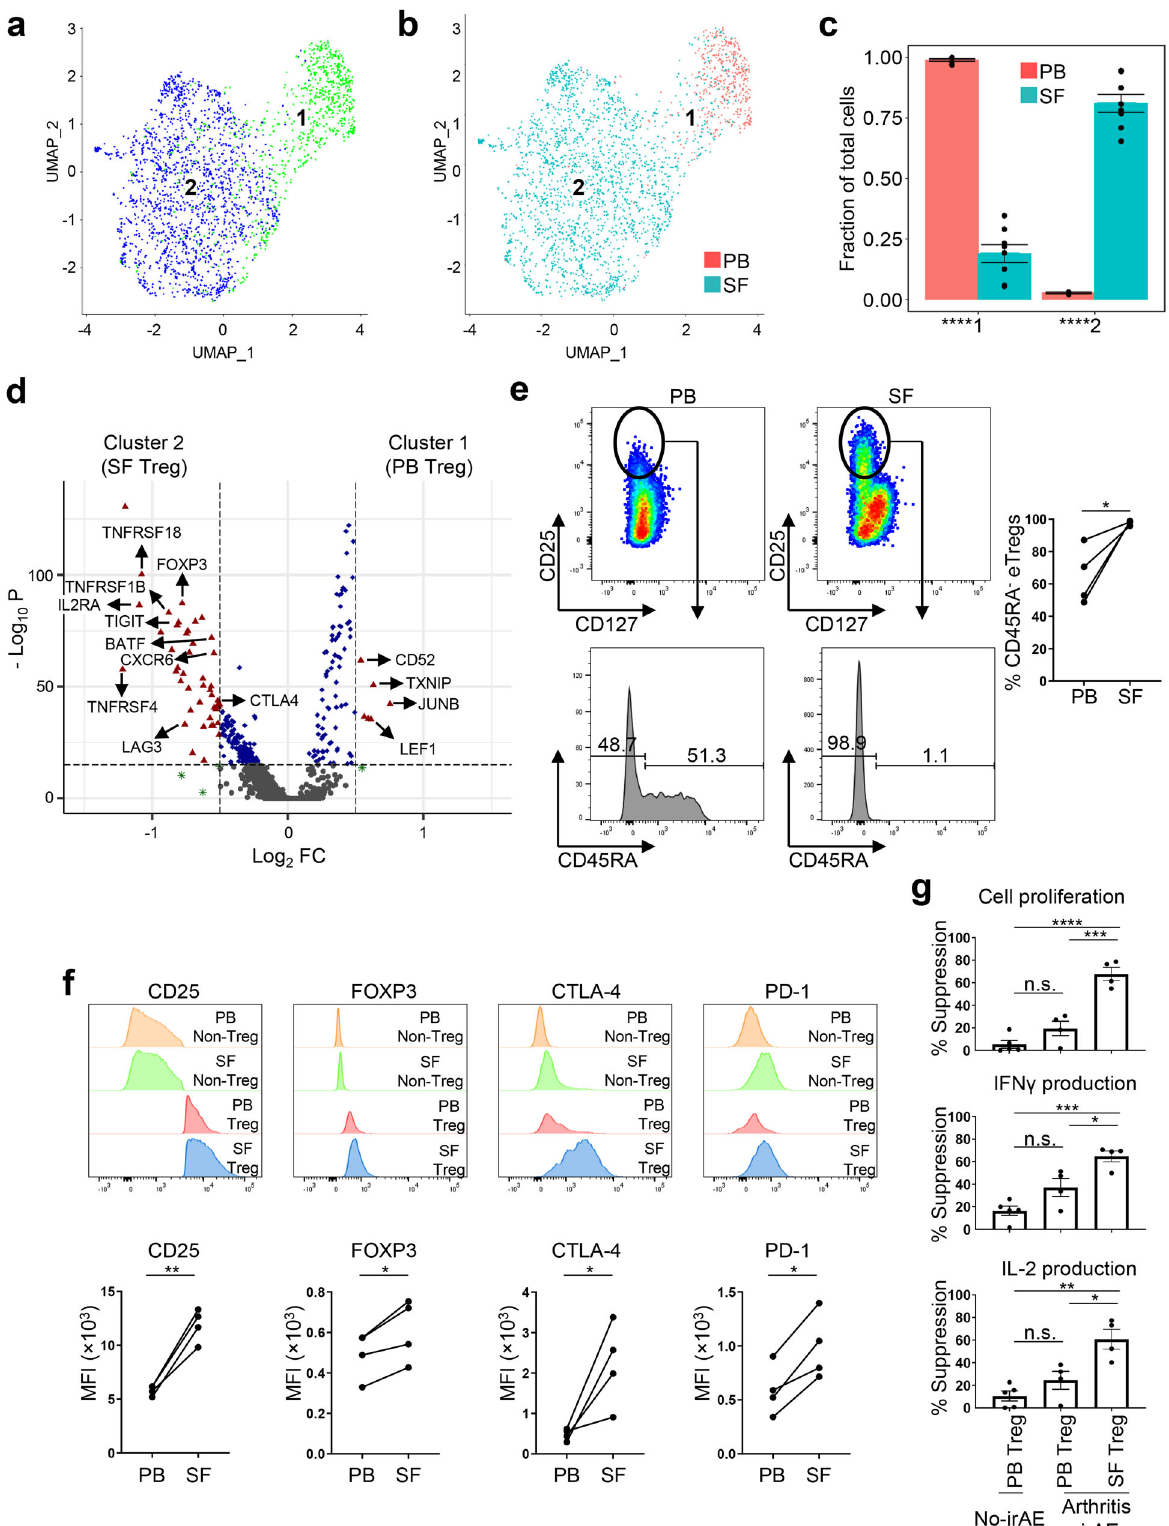
3.42 ± 0.89; P = 0.03). We further investigated the production of IFN γ and IL-17 in CD4 + T cells (Fig. 5a; Supplementary Fig. 6a). Proportions of IFN γ + IL-17 − CD4 + T (Th1) cells were similar between the two groups, whereas IFN γ − IL-17 + CD4 + T (Th17) cells were enriched in the combined ICI arthritis group (% within CD4 + T cells; PD-1 inhibitor arthritis vs. combined ICI